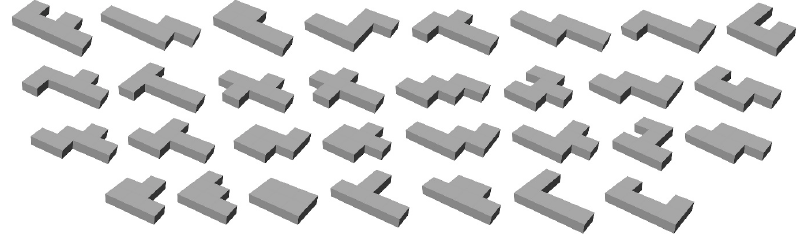
Figure 10. The generated 1-level, ground floor batches (31 building shapes).